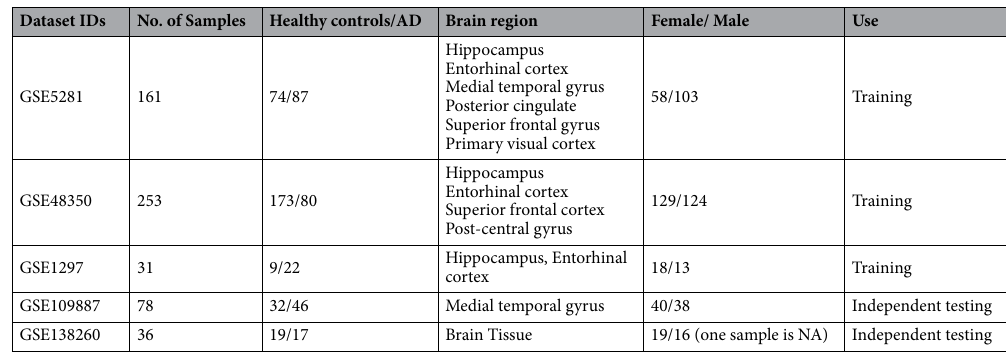
Table 1. Description of the datasets selected for training and independent